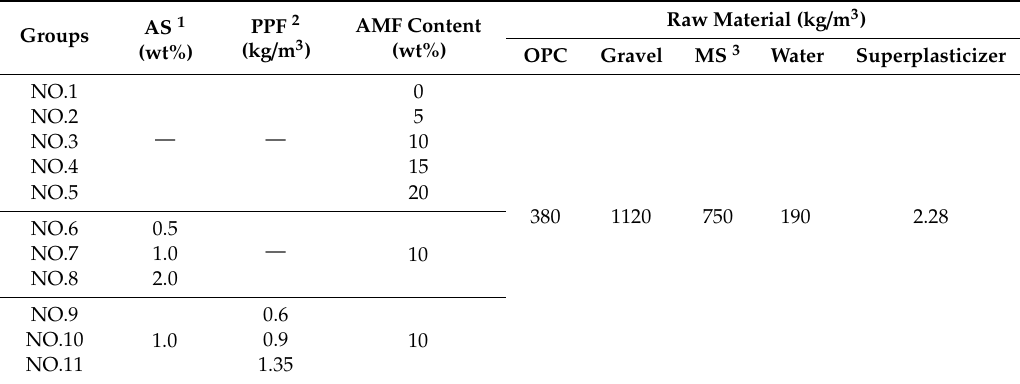
Table 2. Mix Table 2. Mix design.